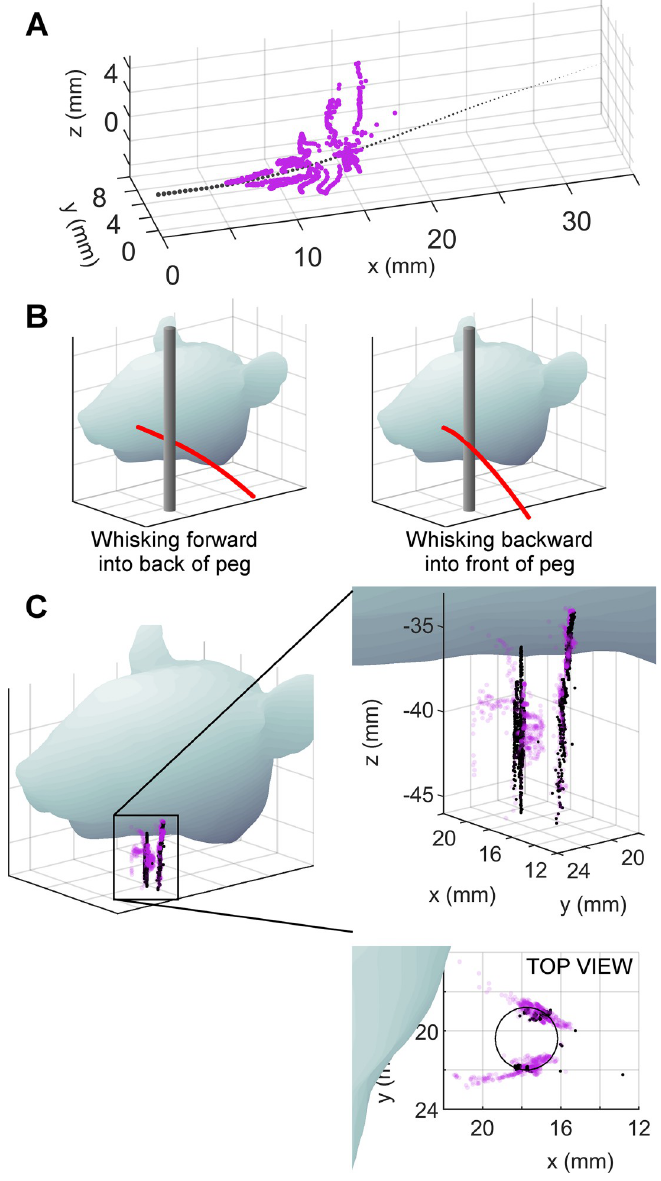
Fig 6. The r wobj , θ wobj , φ wobj coordinates computed from the mechanical signals at the whisker base can reconstruct the shape of the peg. The data in this figure exclude small angle deflections, i.e., any point that lay less than s closest � tan(2˚) from the whisker, where s closest is the arc length of the point on the whisker closest to the contact point. (A) The r wobj , θ wobj , φ wobj coordinates computed from the mechanical signals are plotted in whisker-centered coordinates. The whisker is the black tapered, dotted line. Each magenta dot represents a 3D contact point on the peg with respect to the whisker. Each dot is computed based on mechanical data obtained from a single video frame (1 ms resolution). These are the identical points as were plotted in Fig 4D, but are now plotted in their correct 3D spatial locations relative to the whisker. (B) Diagrams of the rat whisking into the peg show where reconstructed contact points are expected. The rat first whisks forward against the back of the peg, and then whisks backwards against the front of the peg. We therefore expect to see reconstructions of both the front and the back of the peg. (C) The same view of the rat head as in B , now including contact points. Tracked (“ground truth”) contact points are shown as black dots. Contact points computed from mechanical signals are shown as transparent magenta dots. Two expanded views of the reconstructed peg are shown to the right. In the side view, the points create two vertical lines: one indicating contact with the back of the peg, and the other indicating contact with the front of the peg. The top view reveals that the largest errors are found in the estimate of radial distance, rather than in estimates of the angles of contact.